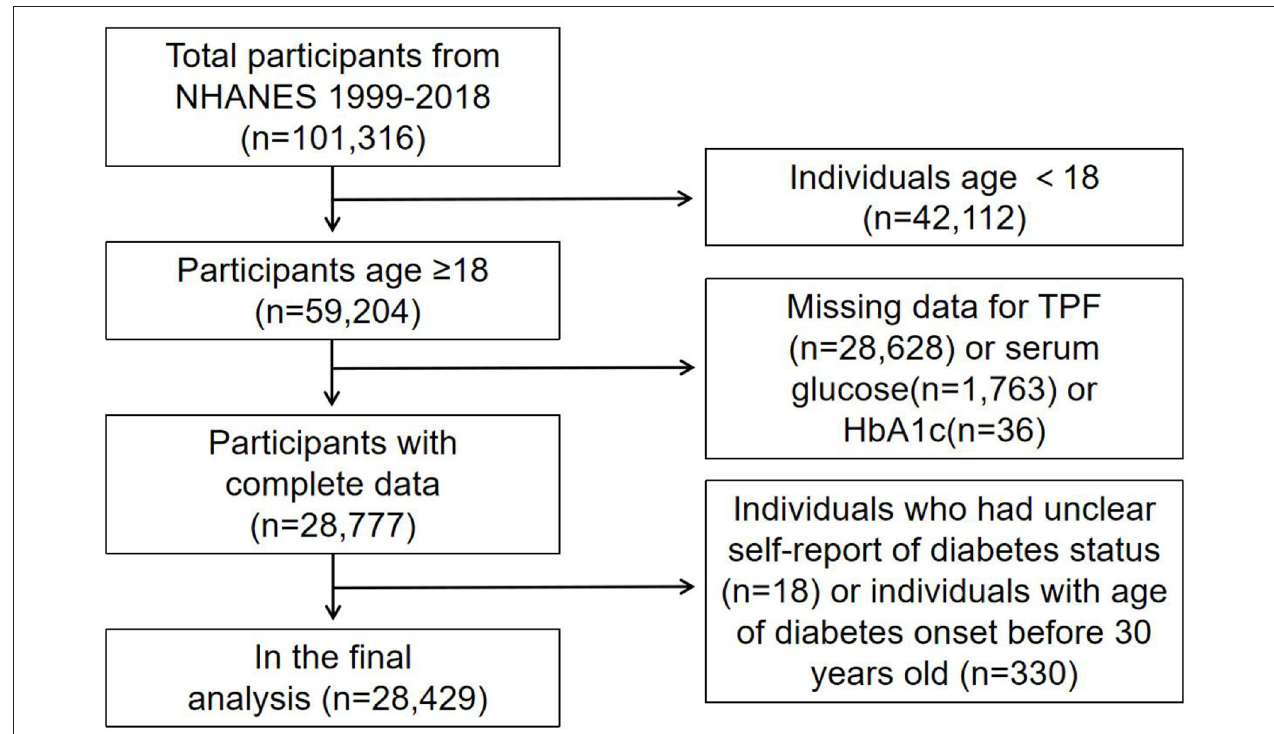
FIGURE 1 | Flow chart of sample selection from the NHANES